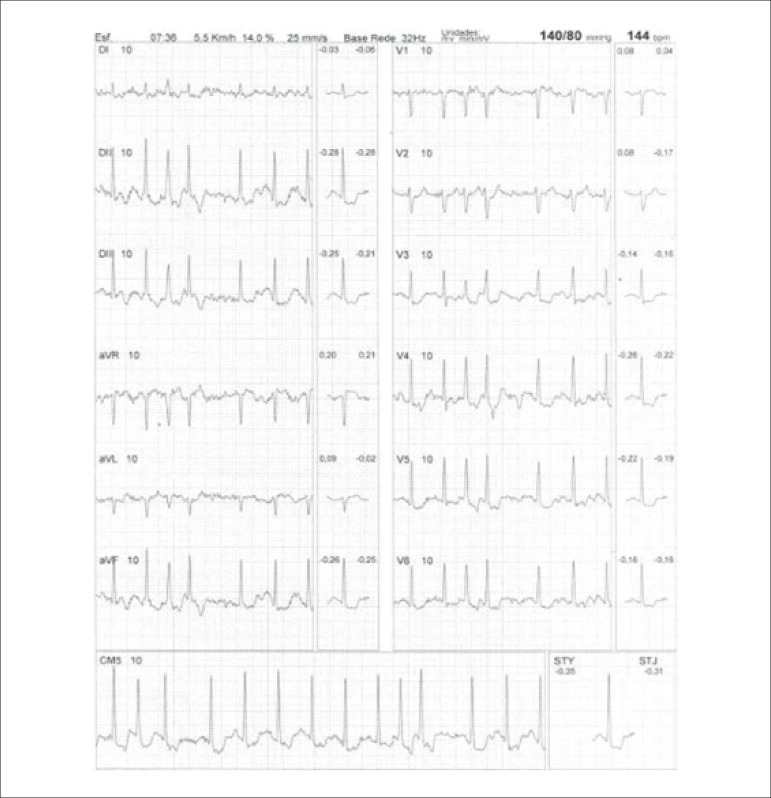
Case 10 - Electrocardiogram tracing demonstrates ischemic ST-segment alterations and episodes of supraventricular arrhythmia, in addition to nonsustained ventricular tachycardia.